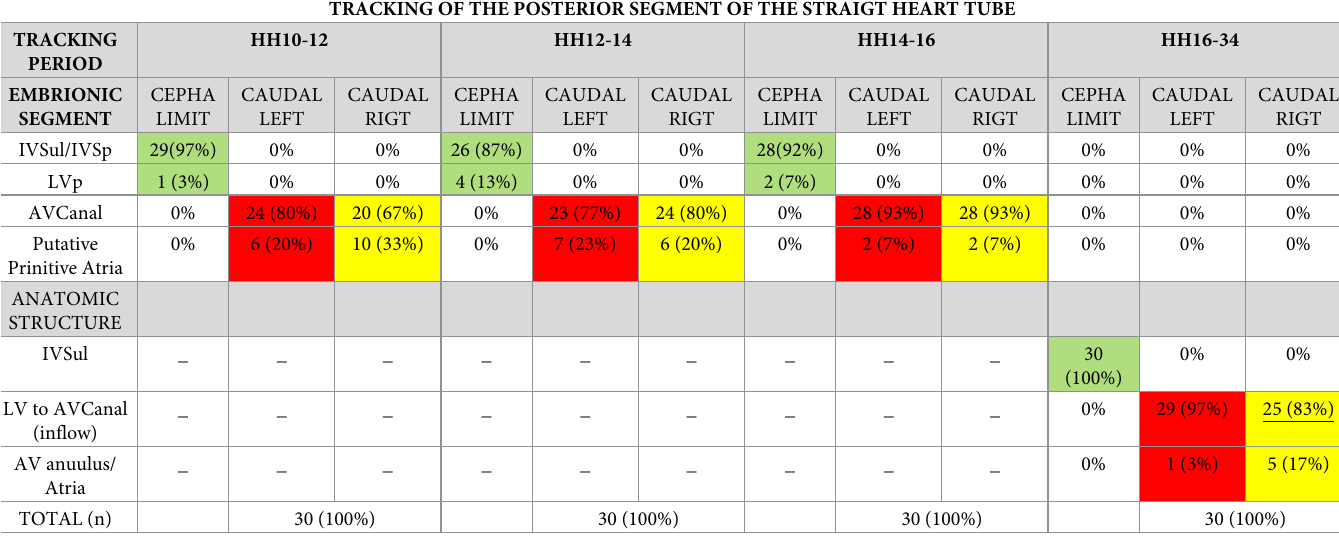
Embryonic segments: AV annulus, atrioventricular annulus; pIVS, primitive interventricular septum; LVp, left ventricle primordium. Anatomical Structures: AVC, atrioventricular canal; IVS, interventricular septum; IVSul, interventricular sulcus; LV, left ventricle. Green, red and yellow shading are representing the color of the cephalic and caudal labels in Figs 1 and